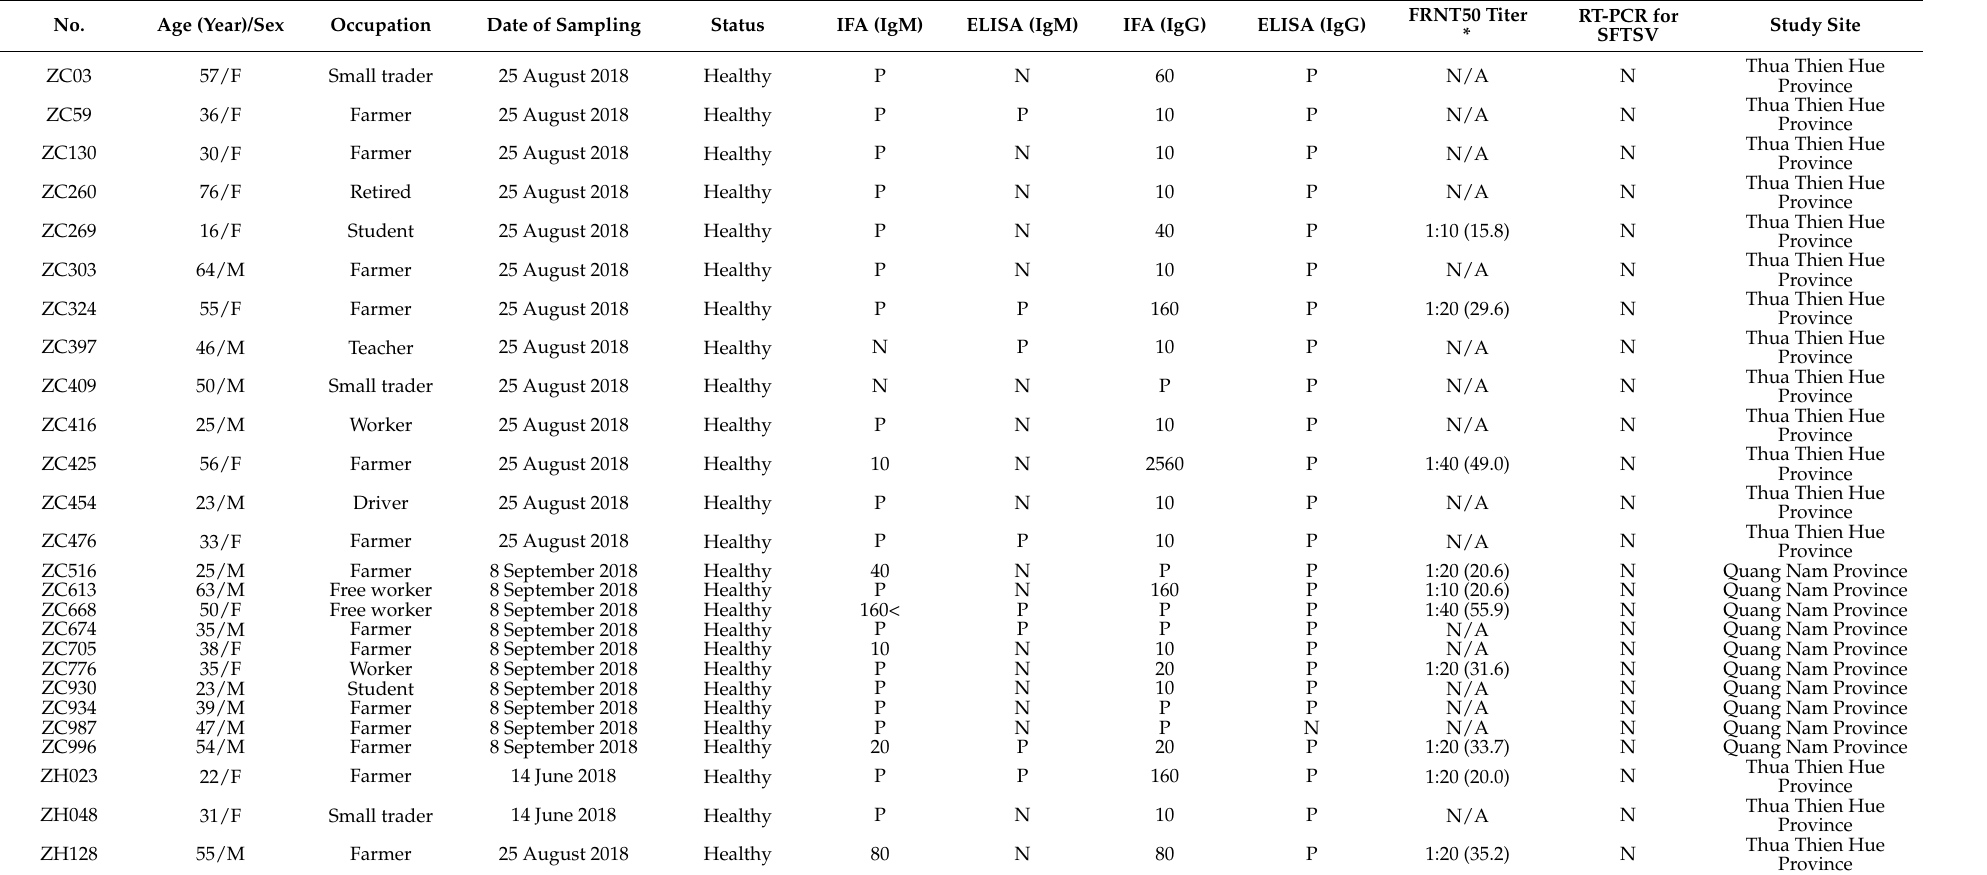
Table 1. Baseline characteristics of healthy residents in SFTSV IgM or G-positive